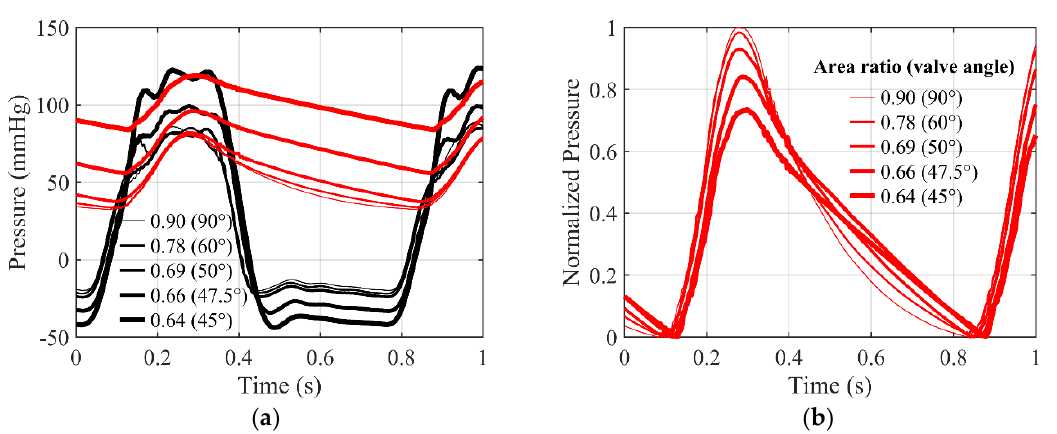
Figure 9. Experiment result according to resistance valve: ( a ) measured pressure waveforms, : ventricular pressure, : aortic pressure; ( b ) normalized aortic pressure waveform according to valve angle.